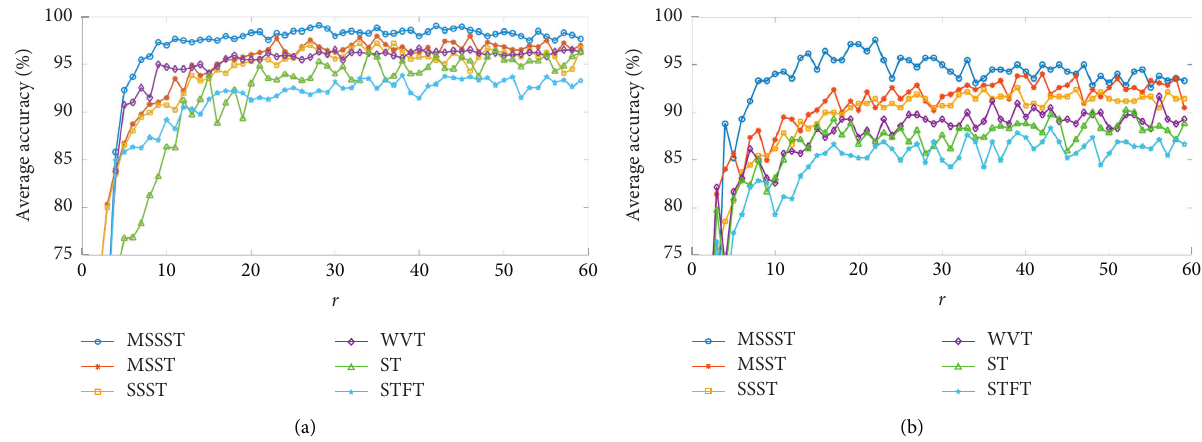
Figure 6: Average recognition accuracy of validation set under different r (a) in the CWRU dataset; (b) in the MFPT dataset.